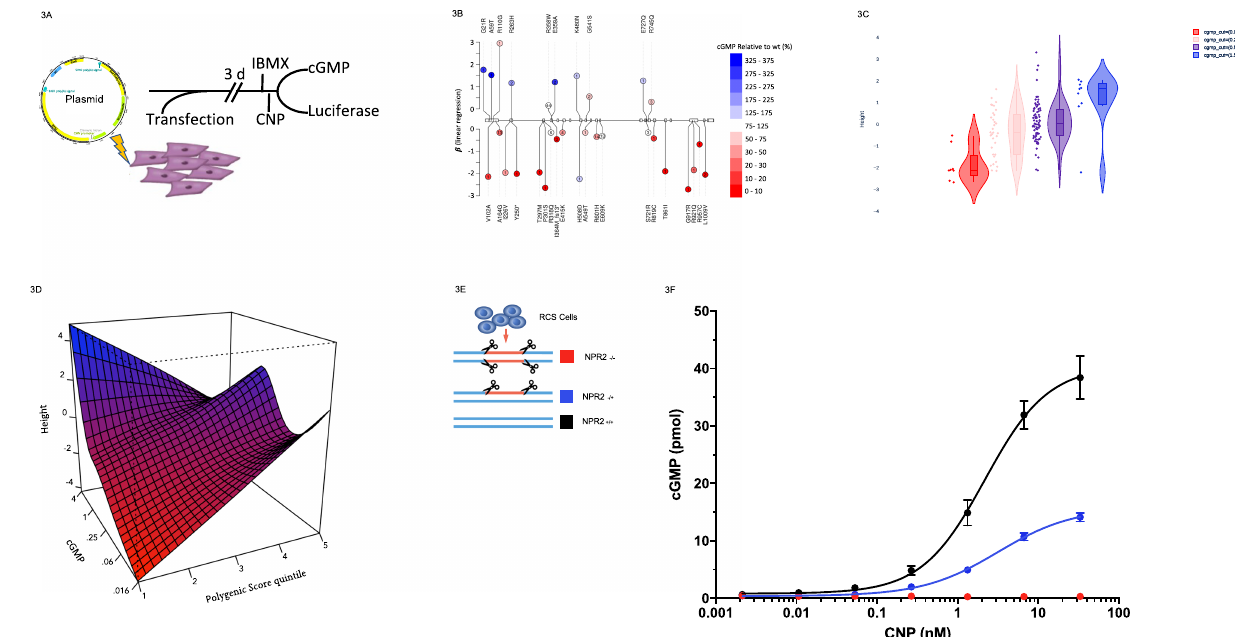
Fig. 3 Functional effects of NPR2 protein coding variants. A Schematic for evaluation of missense variants. The bicistronic plasmid with a CMV promoter driving production of NPR2 variants and an EF1a promoter driving production of red fi re fl y luciferase was transfected into HEK293T cells. Three days post transfection cells were treated with IBMX, incubated with CNP, and analyzed for luciferase and cGMP activity. cGMP activity was normalized of variants relative to luciferase, n = 3 biologically independent samples. B Diagram of NPR2 protein-altering variants identi fi ed in the UKBiobank study. X -axis indicates genomic position. Y -axis indicates effect size ( β ) of a linear regression of that variant on height in standard deviations. Each circle represents a different variant with the number of carriers inside the circle, amino acid change of the variant is labeled at the end of the circle. Color code indicates cGMP activity of variants relative to luciferase. Source data are provided in Supplementary Table 4. C Violin plots representing height of carriers of the NPR2 variants tested in functional analyses. Box-plots inside violin plots represent the median and inter-quantile range of height in the group. Whiskers are 95% CI. Color categories represent binned cGMP functional readout. Source data are provided in Supplementary Table 4. D Predicted measured height (Z- transformed) as a function of their PS and the percent of wild-type cGMP observed for their NPR2 variant. The color maps to height (blue = highest, red = lowest). Source data are provided in Supplementary Table 5. E Schematic for generating NPR2 de fi cient cells using CRISPR/Cas9. F cGMP dose response to CNP treatment with NPR2 knockout (red), heterozygous knockout (blue), or wild-type (black) cells, n = 3 biological independent samples; error bars represent mean ± s.d. Source data are provided as Source Data fi